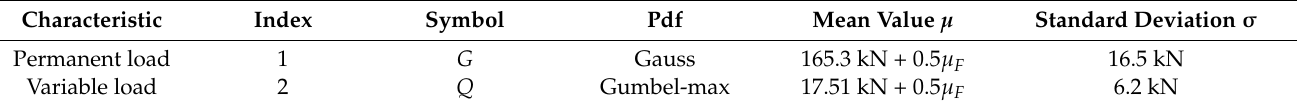
Table 1. The load action A —input random variables.